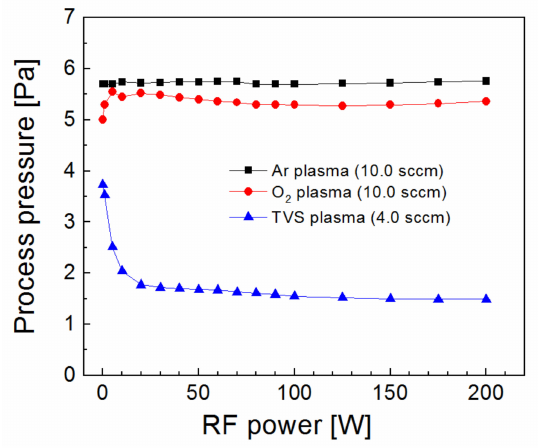
Figure 1. Process pressure as a function of radiofrequency (RF) power for argon, oxygen, and tetravinylsilane (TVS) plasma at a given flow